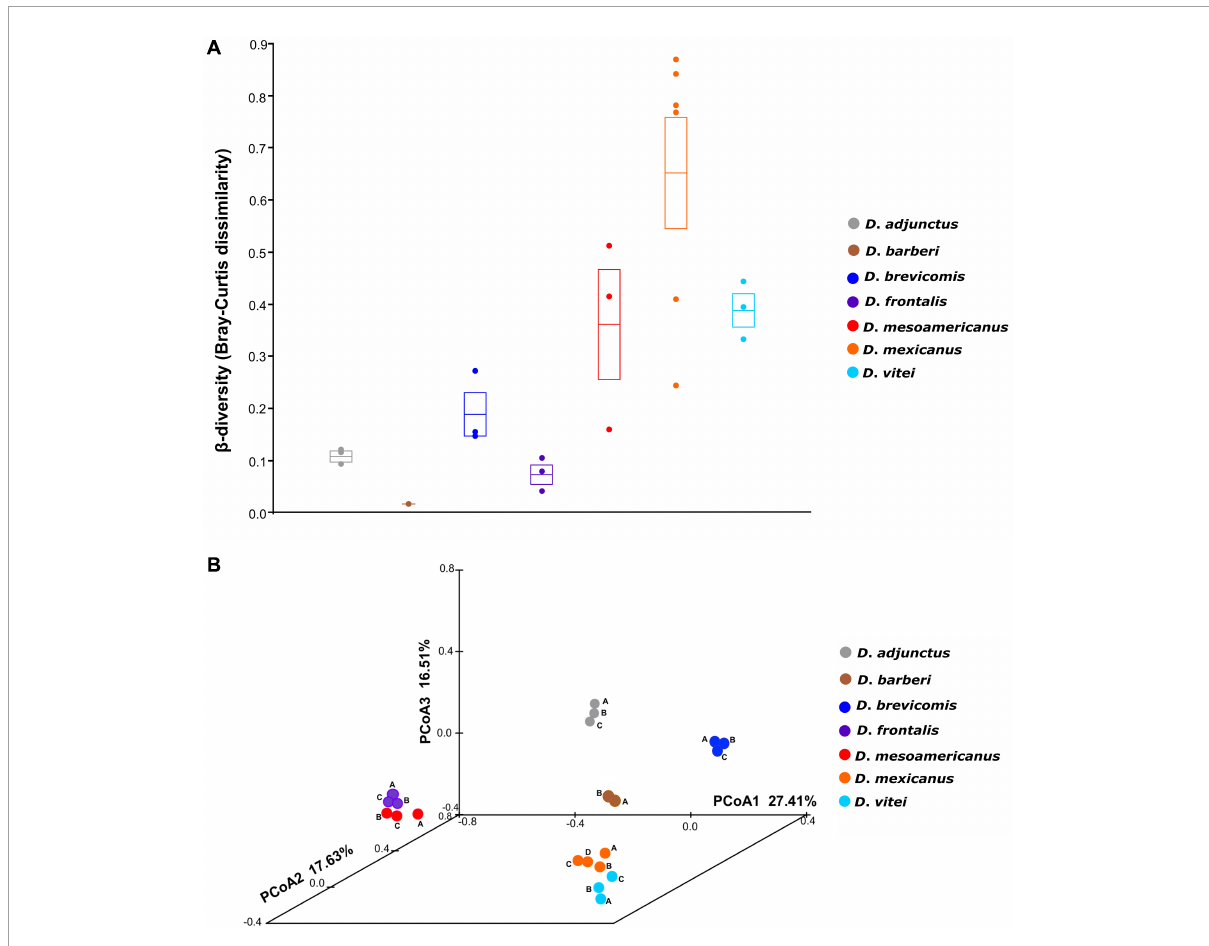
FIGURE2 Beta-diversity and principal coordinate analysis (PCoA) based on Bray-Curtis dissimilarity. (A) Significant differences among in the mycangial fungal communities from the species of the D . frontalis complex (ANOSIM, p = 0.001). The circles represent pairwise Bray-Curtis dissimilarity values between biological replicates from species of the D. frontalis complex; the transversal line and ends in the box represent the mean and its standard error. (B) PCoA plot depicting variation in a multidimensional space of mycetangial fungal assemblages from the species of the D . frontalis complex; the first three PCoA coordinates explained 61.55% of the total observed variation; dots of the same color represent biological replicates (A, B, C) of the same bark beetle species, except for D . mexicanus (A, B, C, D) and D . barberi (A,